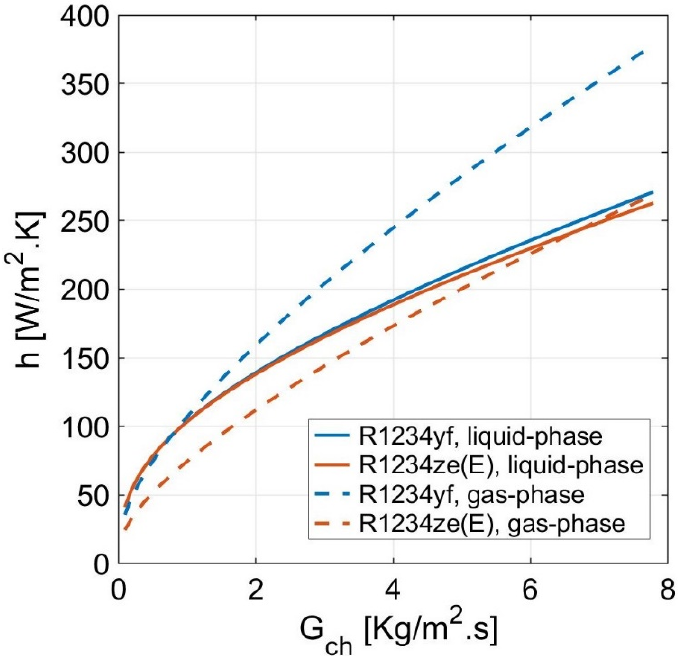
Figure 5. Cold stream liquid-phase and gas-phase convection coefficients at various cold channel mass fluxes.